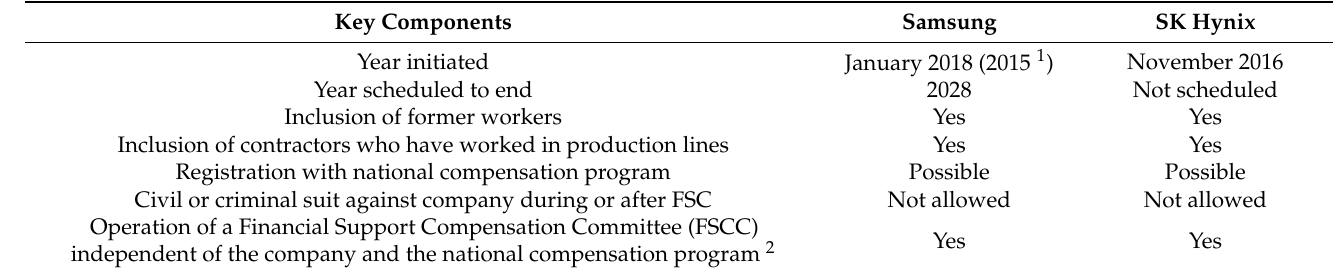
Table 1. Overview of the financial support compensation (FSC) programs operated by the two semiconductor